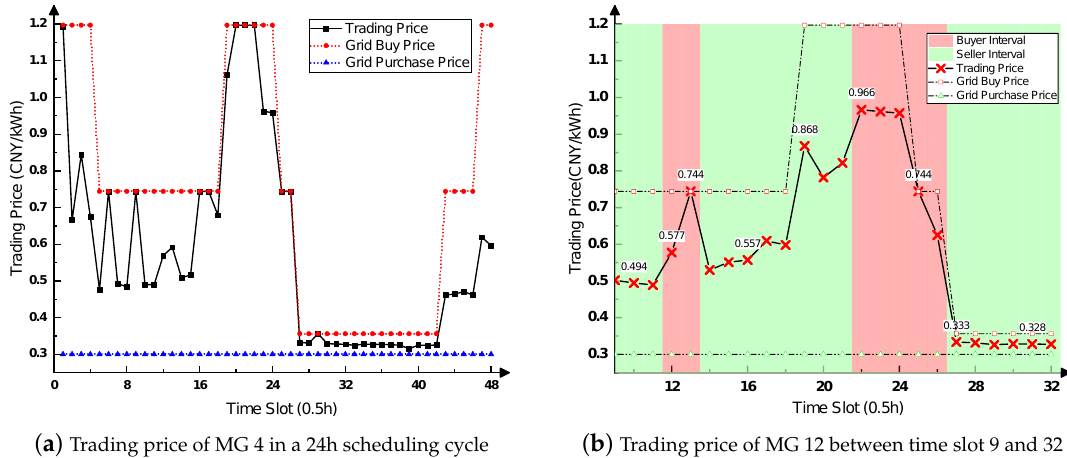
( b ) Trading price of MG 12 between time slot 9 and 32 Figure 12. Energy trading price of MG 4 and MG